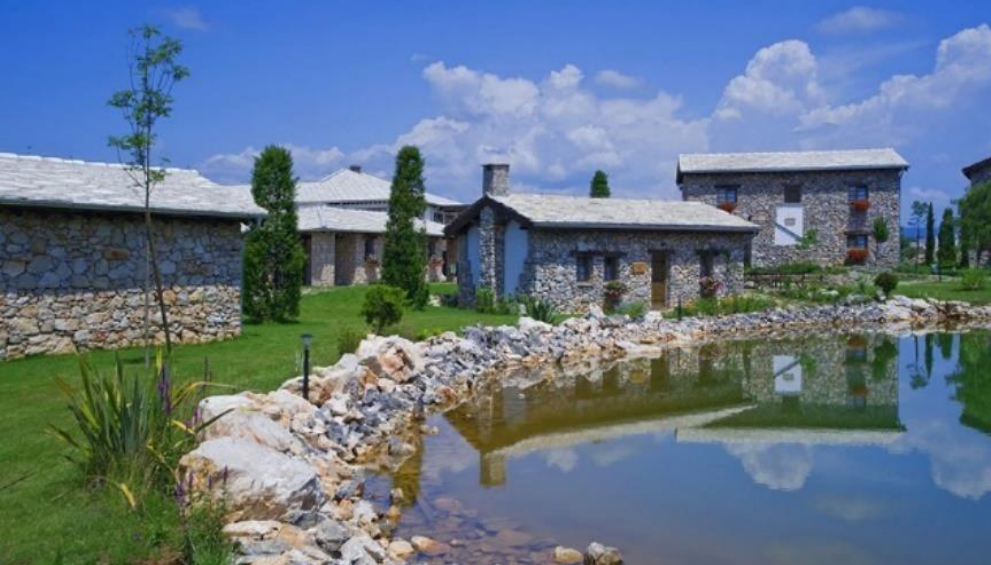
Figure 1. Herceg ethno village (Source: https://www.etno-herceg.com/en/about-us-herceg-ethno-village-